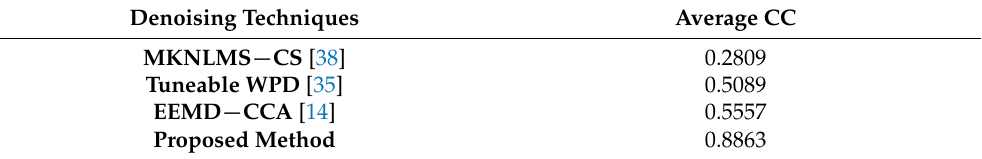
Table 7. Comparison of similarity between C-EEG and reconstructed clean EEG (ranges from 4.3 s to 7.3 s).